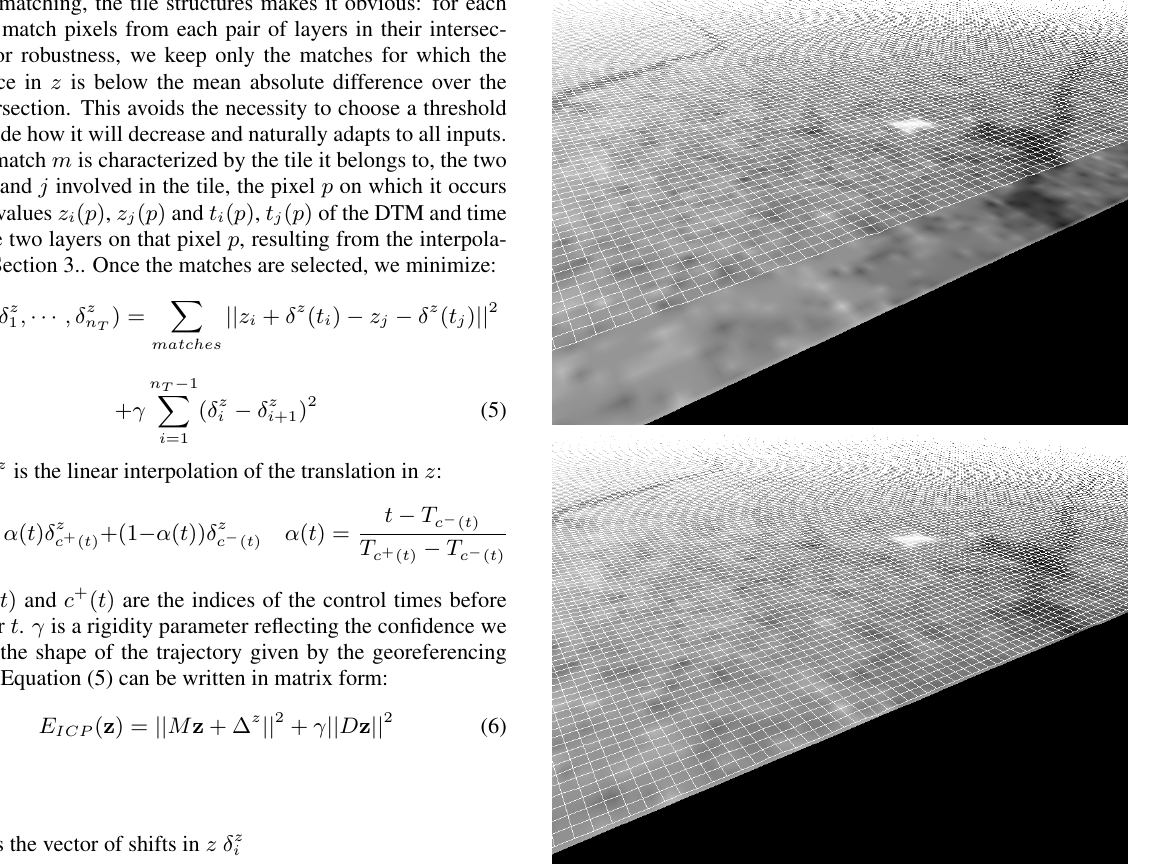
Figure 6: Registration result for two DTM layers (one textured and one in white wireframe). Top: before registration.